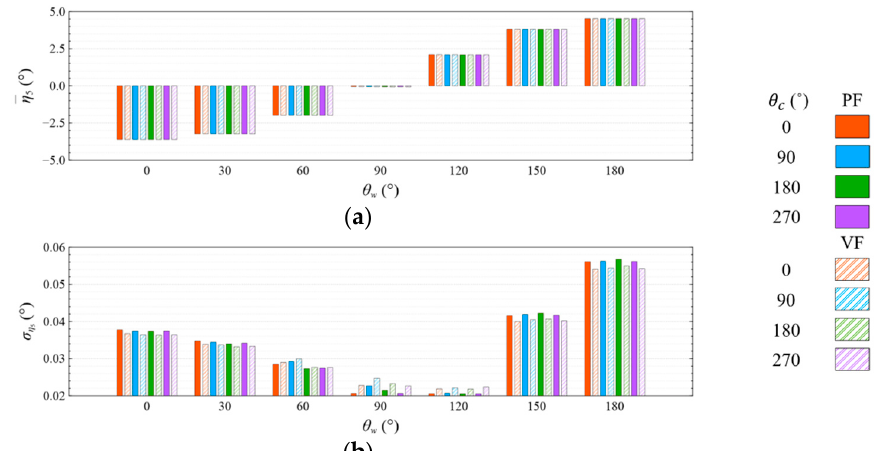
Figure 18. Comparison of ( a ) means and ( b ) standard deviations of platform pitch motion under CW condition.